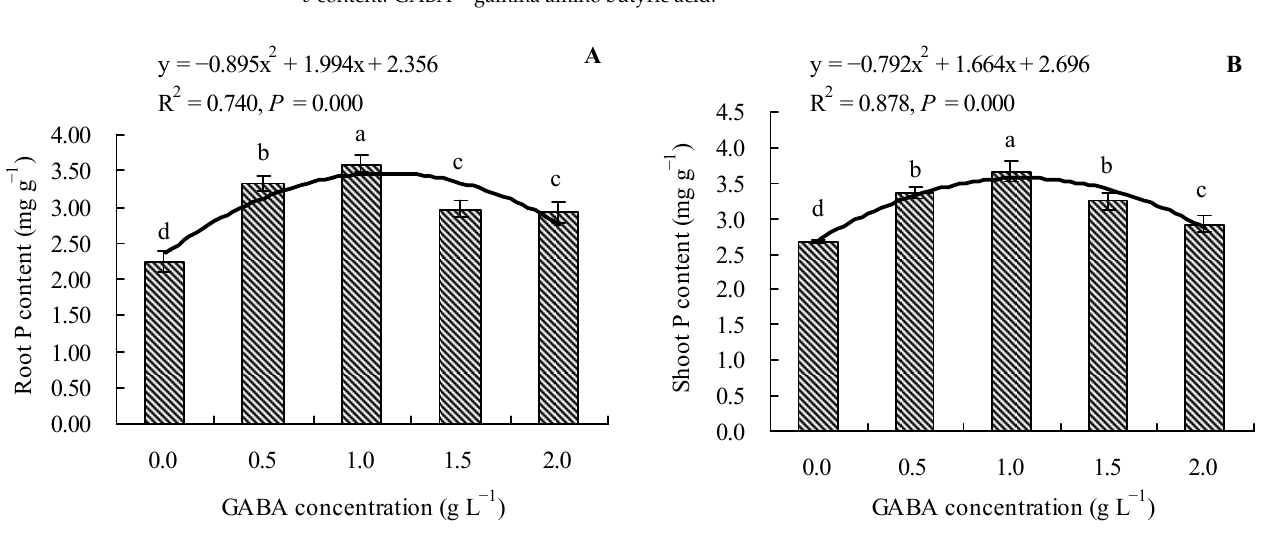
Values are means ( ± SD) of three replicates. Different letters indicate significant differences among the treatments (Duncan’s Multiple Range Test, P < 0.05). Chlorophyll a / b was calculated as the chlorophyll a content/chlorophyll b content. GABA = gamma amino butyric acid.